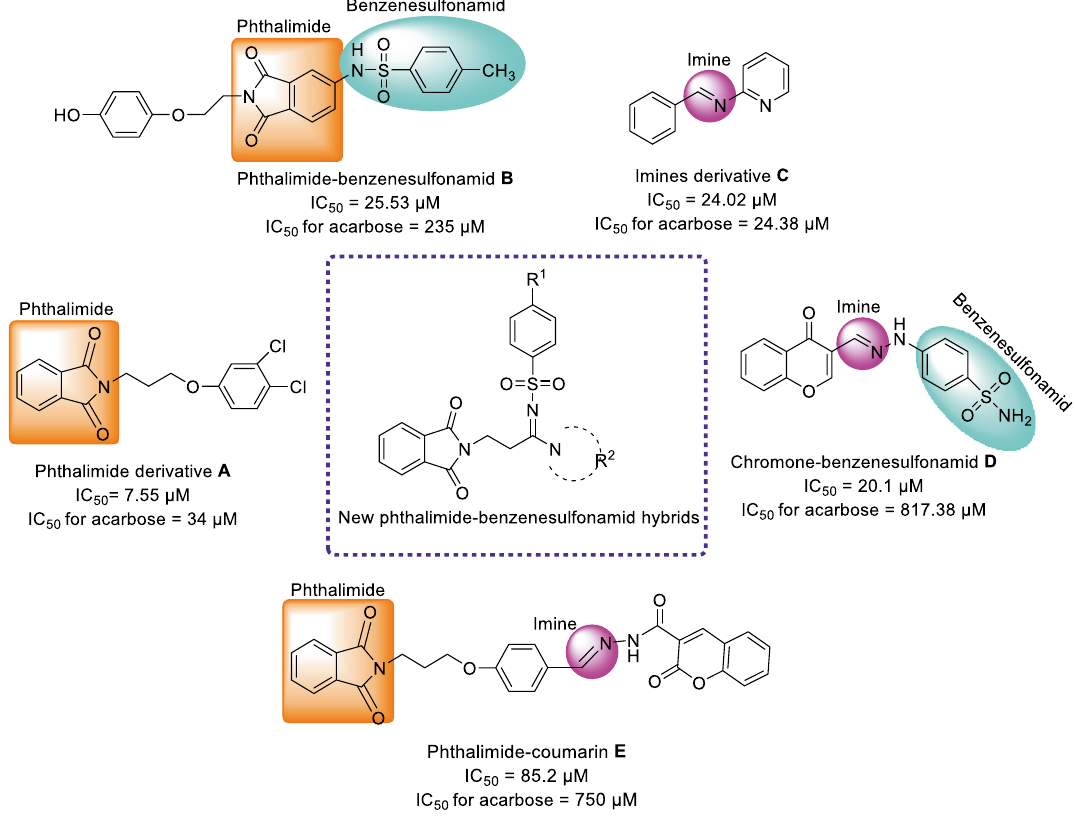
Figure 2. Design strategy for phthalimide-benzenesulfonamide hybrids based on scaffolds of the potent α -glucosidase inhibitors ( A – E ) (ChemDraw